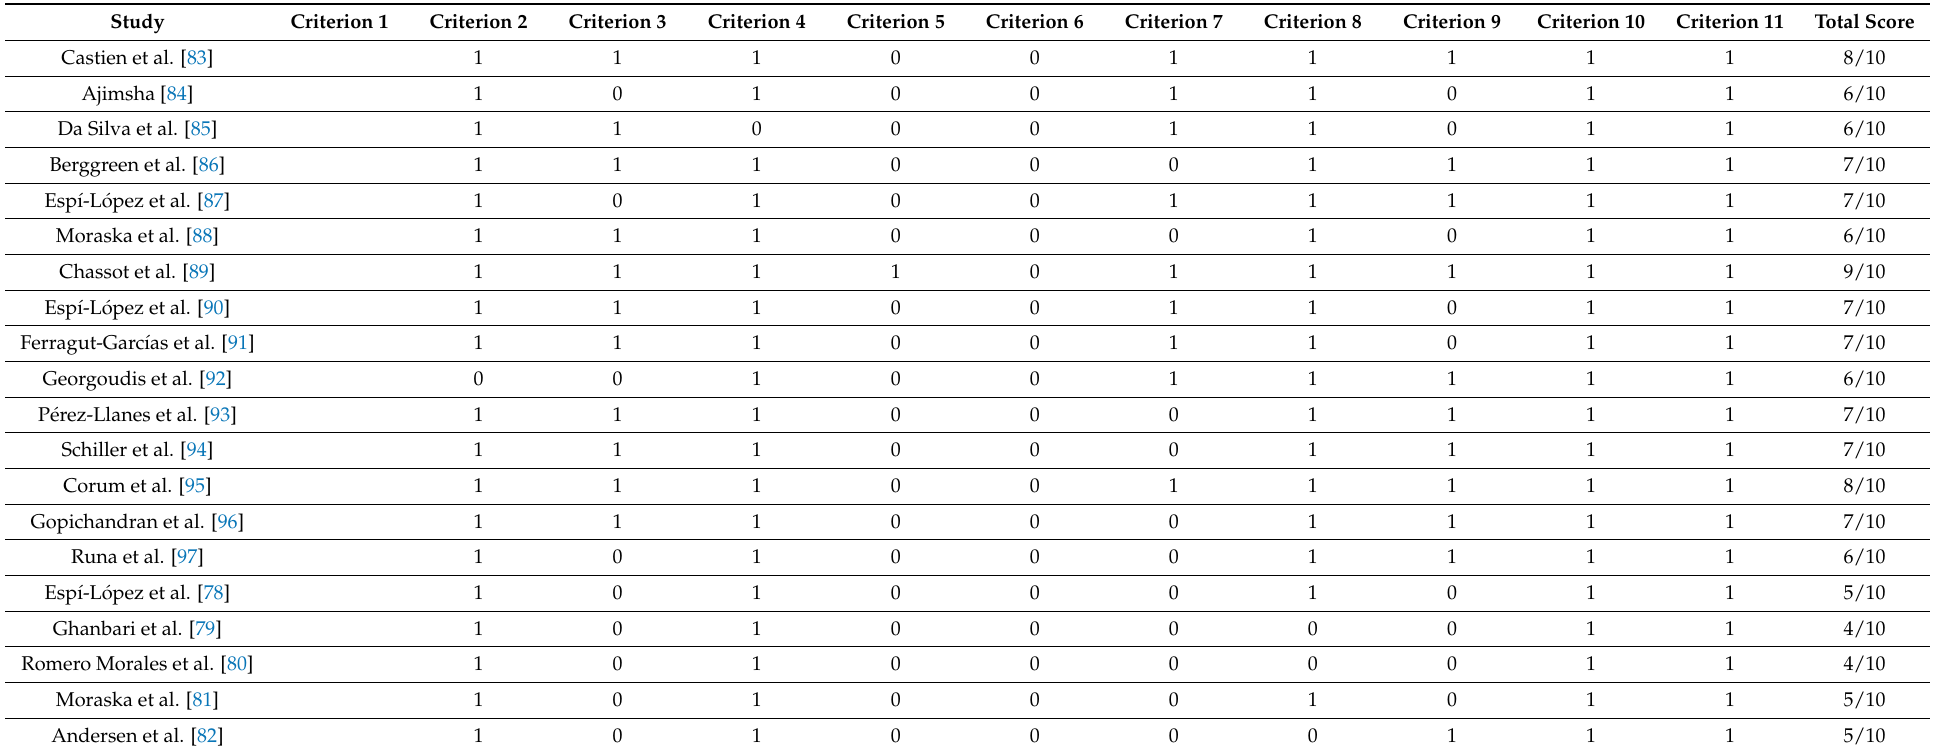
Table 1. Risk of bias within studies using PEDro